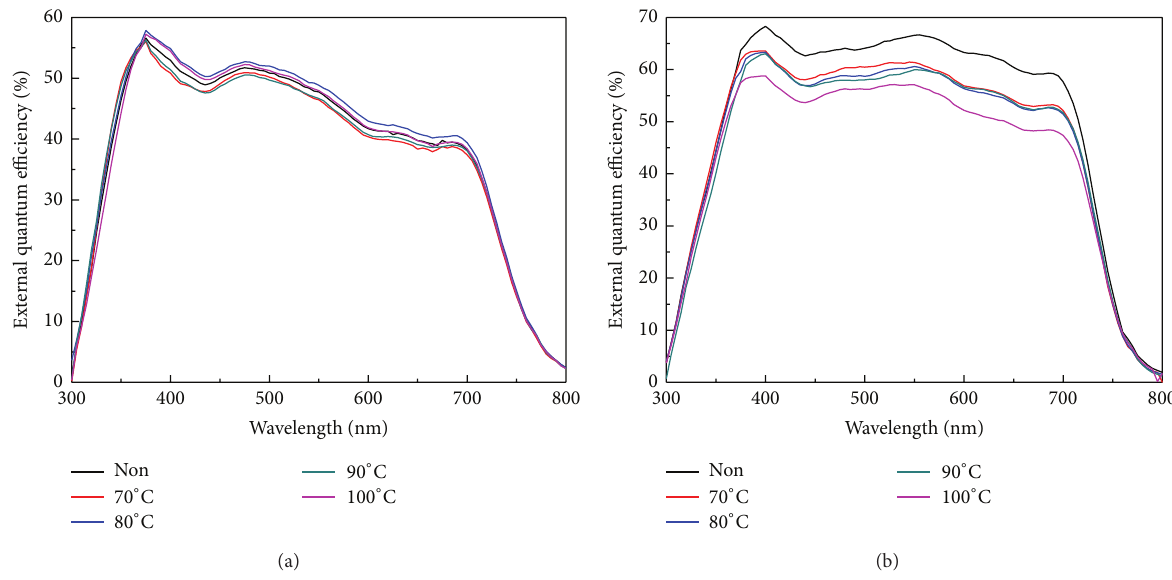
Figure 3: The EQE spectra of the OPV devices with the PBDTTT-C:PC 71 BM layers (a) without DIO and (b) with 3% DIO heated under different temperatures for 5